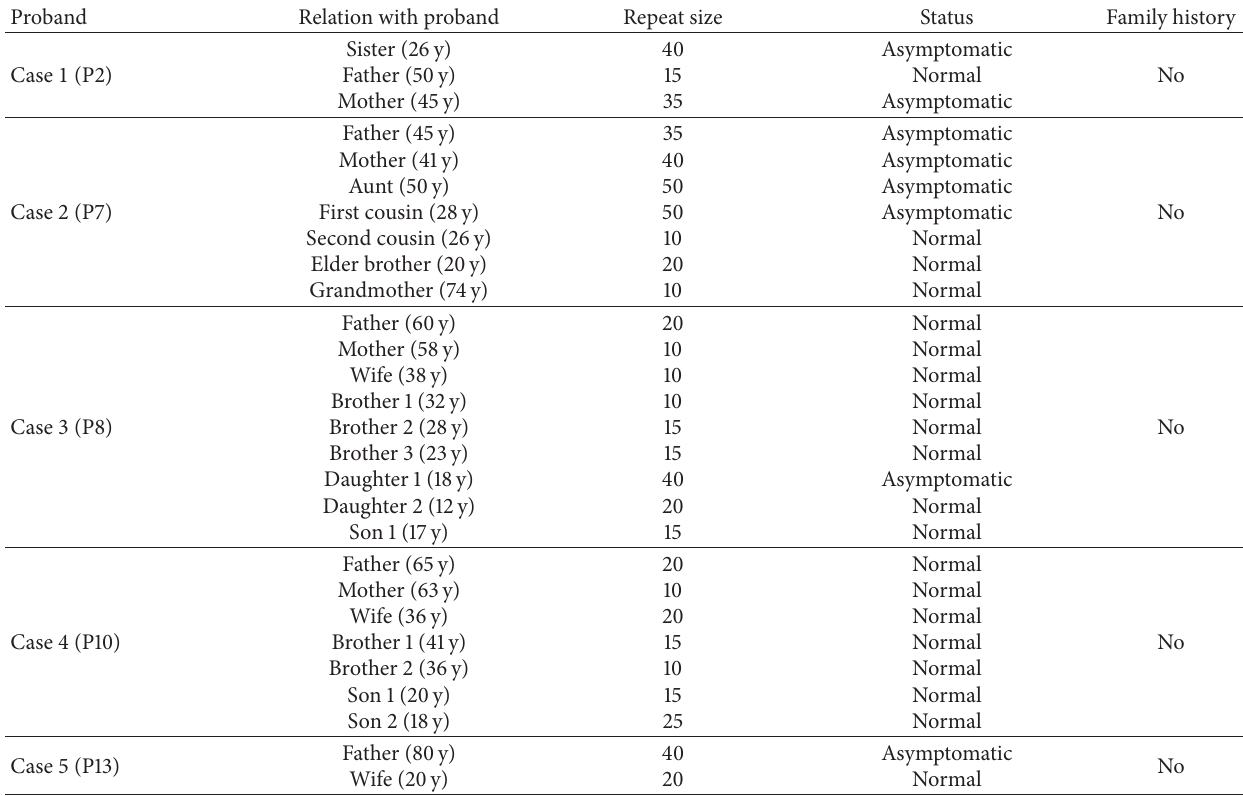
Table 3: Molecular profile of the proband family